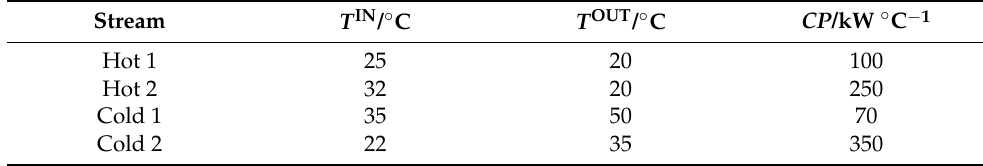
Table 5. Input data for the process streams for case study 2.